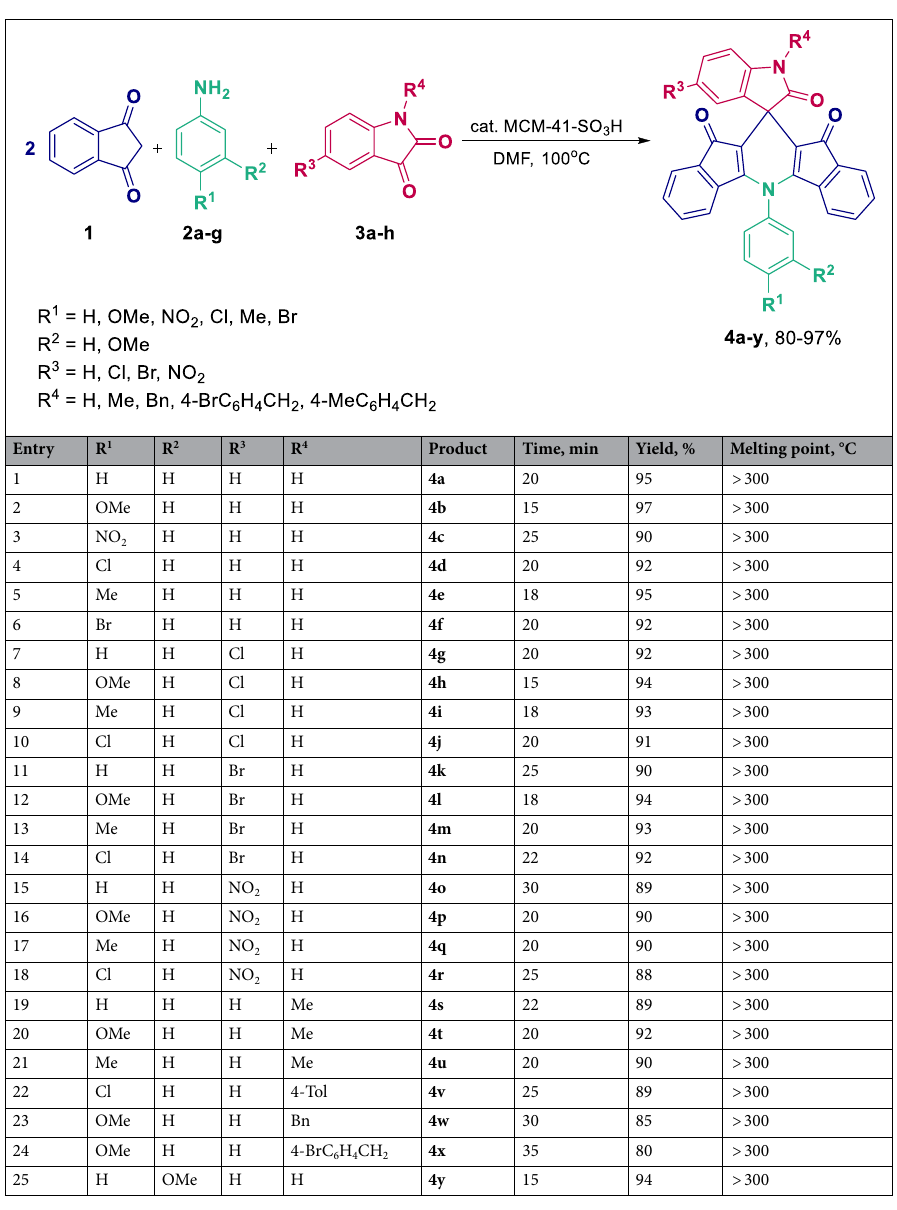
Table 4. Synthesis of spiro[diindeno[1,2- b :2 ′ ,1 ′ - e ]pyridine-11,3 ′ -indoline]-2 ′ ,10,12-triones.